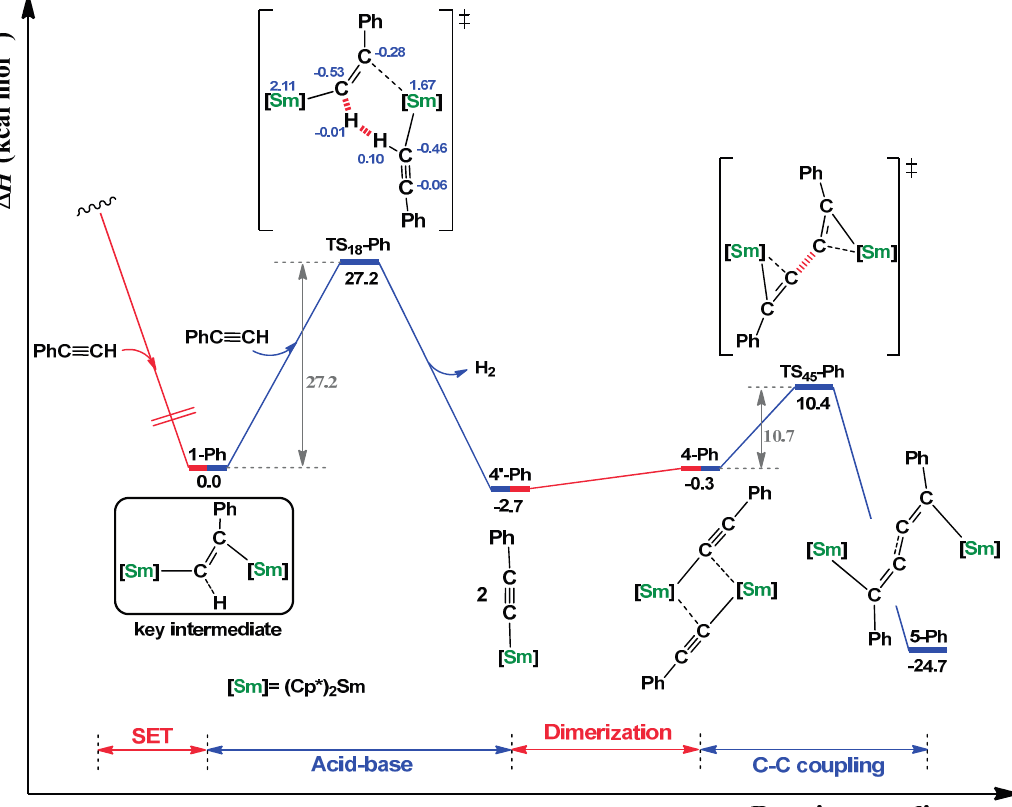
Figure 5. Enthalpy energy Δ H (kcal·mol − 1 ) profile for the formation of the corresponding trienediyl complex using PhC ≡ CH as substrate and (Cp * ) 2 Sm as a precursor (Mechanism B). Cp * ligands are omitted for clarity. Numbers in blue correspond to natural